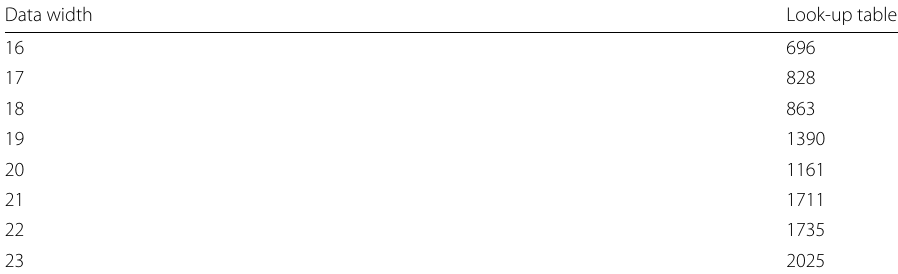
Table 8 Resource utilization of the sine/complement generators Data width